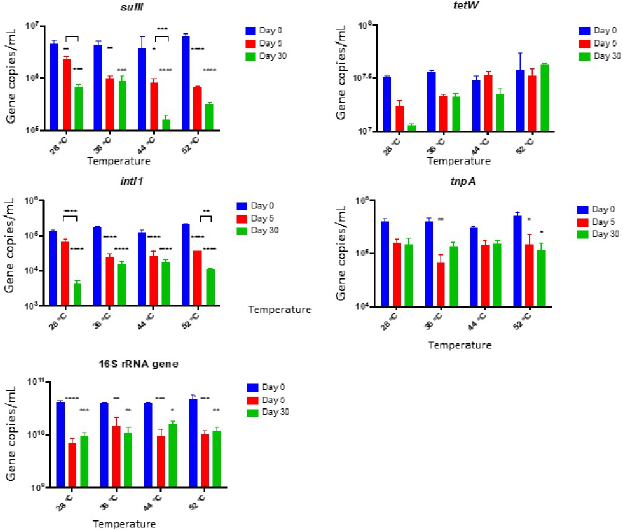
Fig 2. Absolute abundance of ARGs and MGEs at Day 0, 5, 30 in anaerobic digestion. Values represent the means based on three replicates. Stars on bars of Day 5 and Day 30 represent their p value when gene AAs were compared with the corresponded initial value (Day 0). Stars on square brackets showed p value of comparison between Day 5 and Day 30. Error bars represent standard errors. Symbol and meaning: p � 0.05( � ); p � 0.01( �� ); p � 0.001( ��� ); p � 0.0001( ����